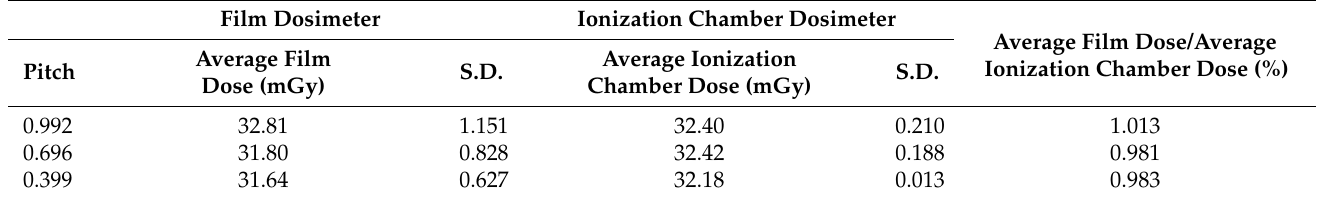
Table 1. Comparison of the measurement performance of the film dosimeter and ionization chamber dosimeter with pitch values of 0.992, 0.696, and